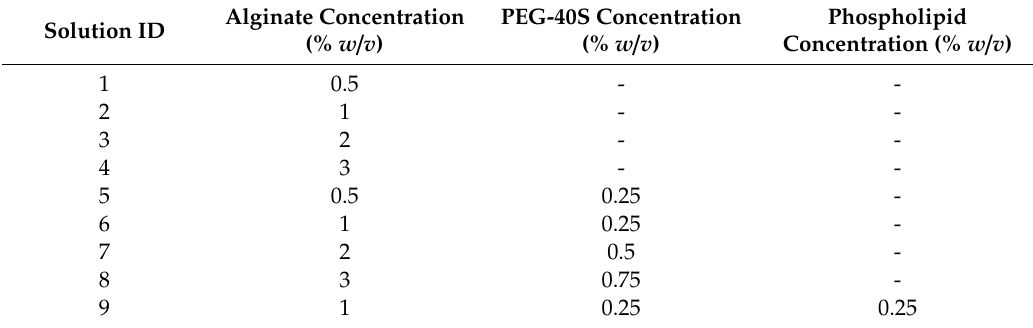
Table 1. Composition of the alginate-based polymeric solutions used in this experimental